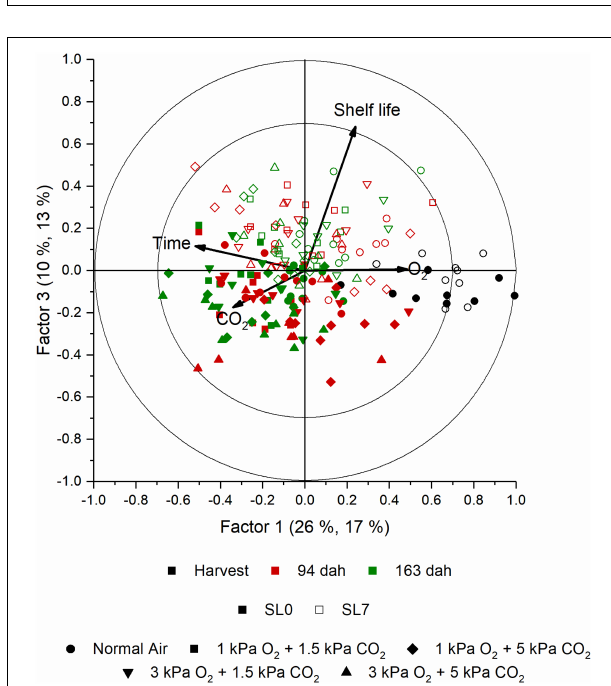
FIGURE 9 | Score plot of factor 1 and 3 obtained with the PLS analysis of the aroma measurement of the cabbage juice using SPME GC-MS. Between the brackets per factor, the first percentage indicates the percentage of which part of the aroma variables are represented in the projection of this dimension, while the second percentage indicates to what extent the response is explained by this. The different objects are color- and shape-coded based on time and treatment, respectively, as indicated in the legend. At each time point, shelf life and storage treatment, nine biological replicates were measured.